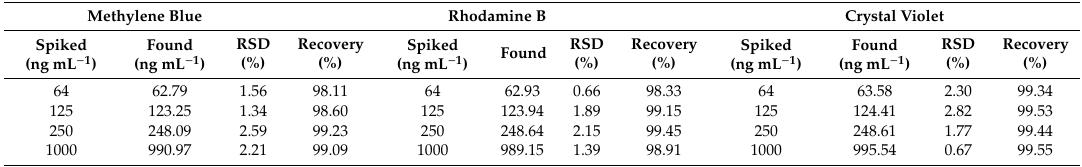
Table 4. Recovery studies for the determination of methylene blue, rhodamine B and crystal violet. Methylene Blue Rhodamine B Crystal Violet RSD Recovery Spiked Found Spiked Found RSD (%) (%) (ng mL − 1 ) (ng mL − 1 ) (ng mL − 1 )